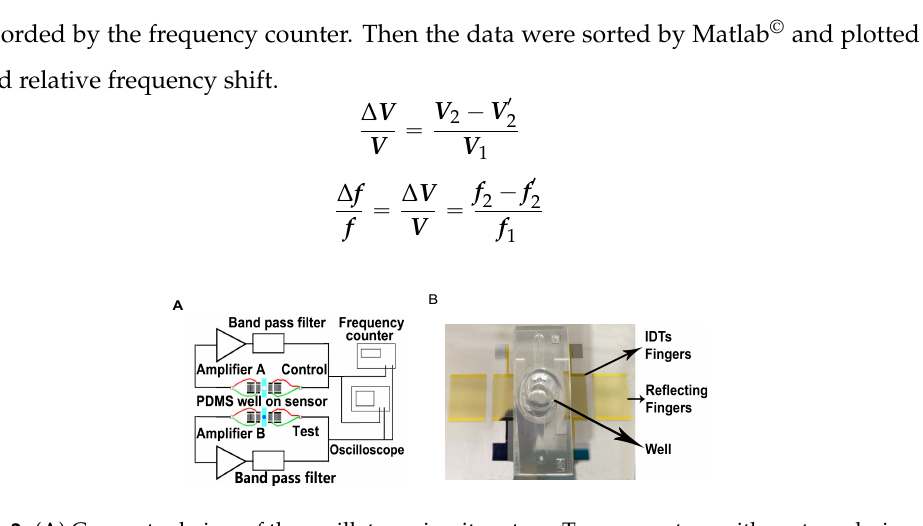
Figure 2. ( A ) Conceptual view of the oscillatory circuit system. Two resonators with custom-designed oscillatory circuit system were used with one of them as control group; ( B ) Fabricated and assembled resonator and fluidic well.